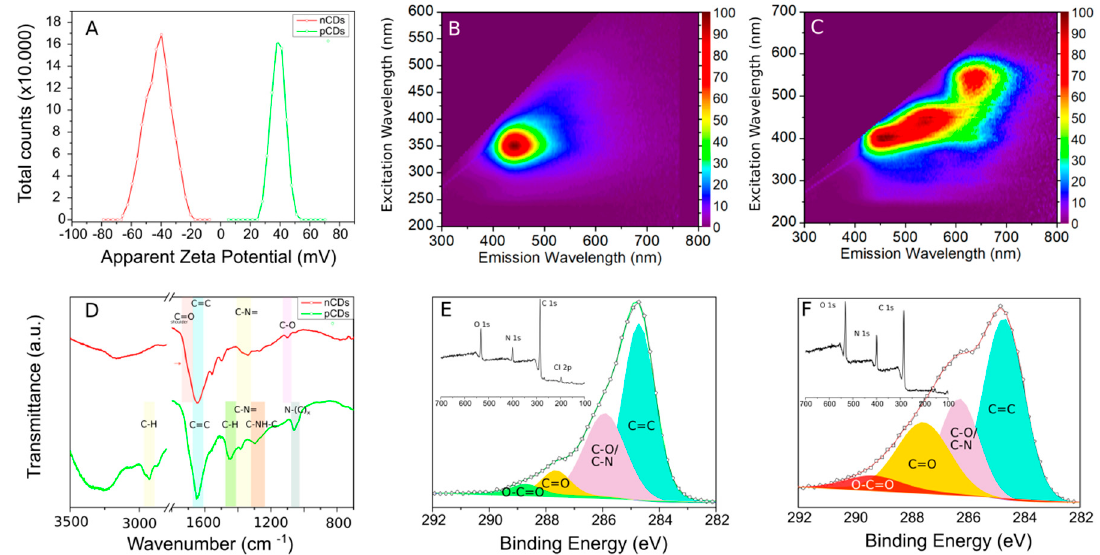
Figure 1. Zeta-potential of the prepared CDs in water at pH 7.0 ( A ); fluorescent excitation-emission map of pCDs ( B ); fluorescent excitation-emission map of nCDs ( C ); FT-IR spectra of pCDs and nCDs with highlighted characteristic vibration bands ( D ); high-resolution C 1s XPS spectrum of pCDs with survey spectrum in the inset ( E ); high-resolution C 1s XPS spectrum of nCDs with survey spectrum in the inset ( F ).